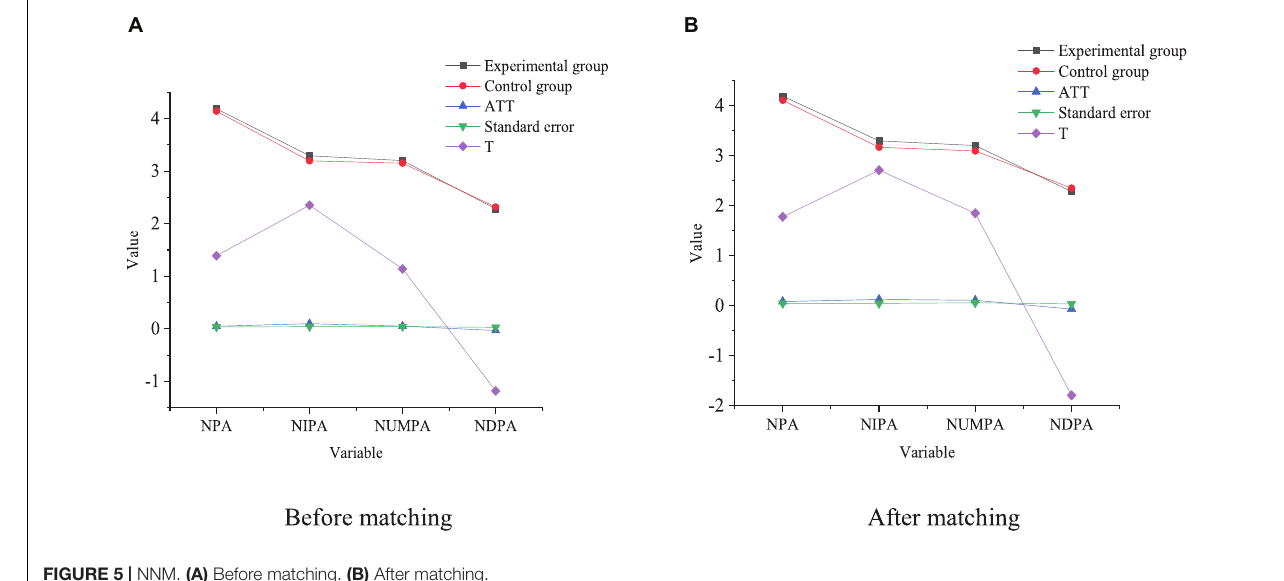
FIGURE 5 | NNM. (A) Before matching. (B) After matching.